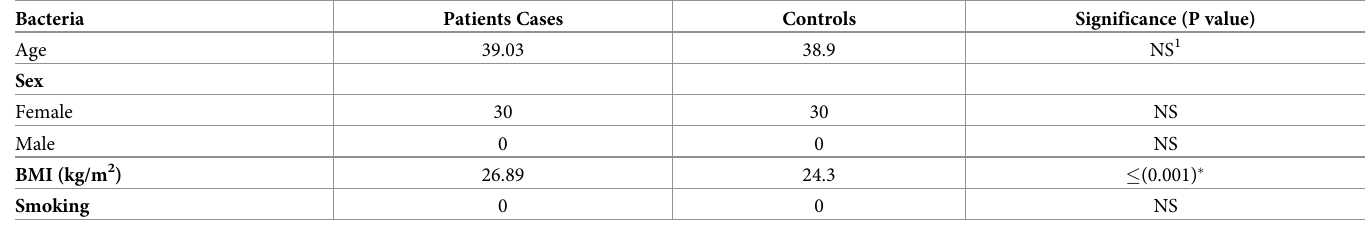
Table 2. Characteristics of MS patients and healthy